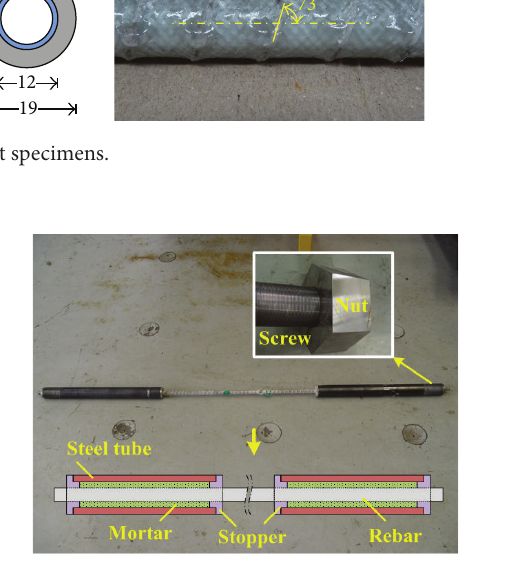
Figure 7: Cross section of test specimens. Figure 8: Gripping